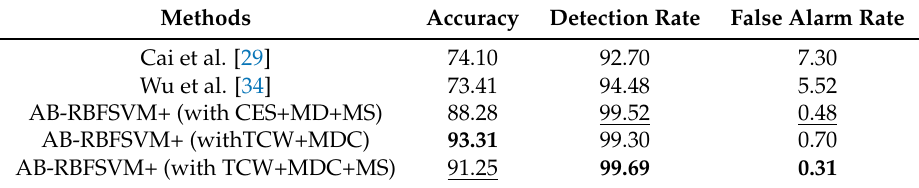
Table 7. Accuracy of our proposed method with different feature combinations, [29,34] (%).